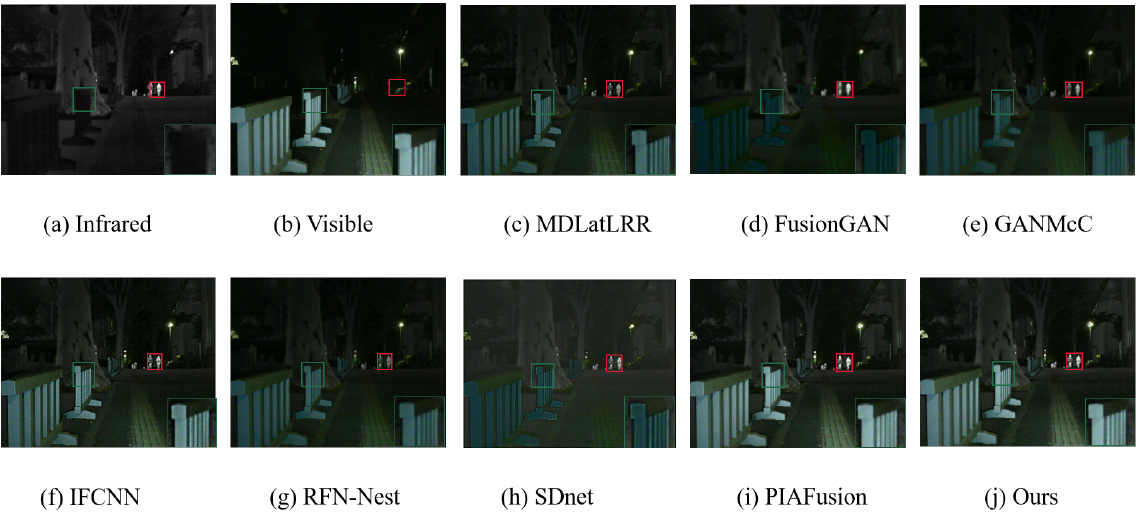
Figure 7. Comparative experiment for different fusion network of a typical nighttime sample from the MSRS dataset.